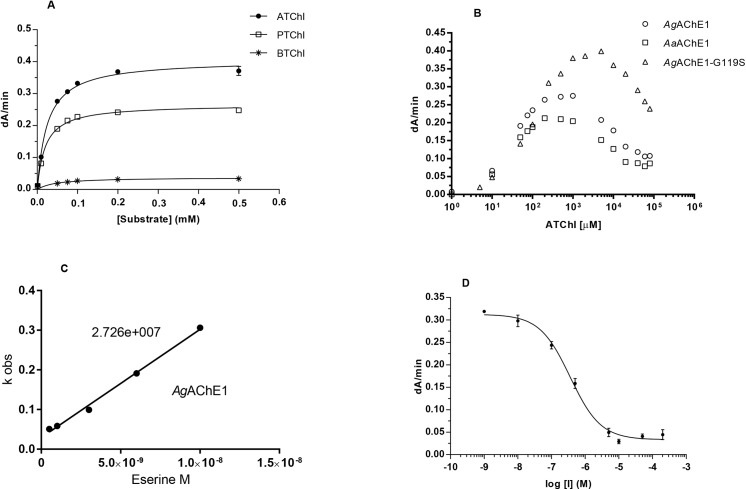
Enzyme kinetics.(A) Substrate preference for AaAChE1 illustrated by Michaelis-Menten curves. The same trend was observed for AgAChE1 and AgAChE1-G119S. (B) Substrate inhibition of AaAChE1, AgAChE1 and AgAChE1-G119S using ATChI as substrate. (C) Typical graph for k
i-calculations of AgAChE1 with eserine as inhibitor. (D) Typical dose-response curve of AaAChE1 with inhibitor, used for determination of IC
50-values for various compounds.